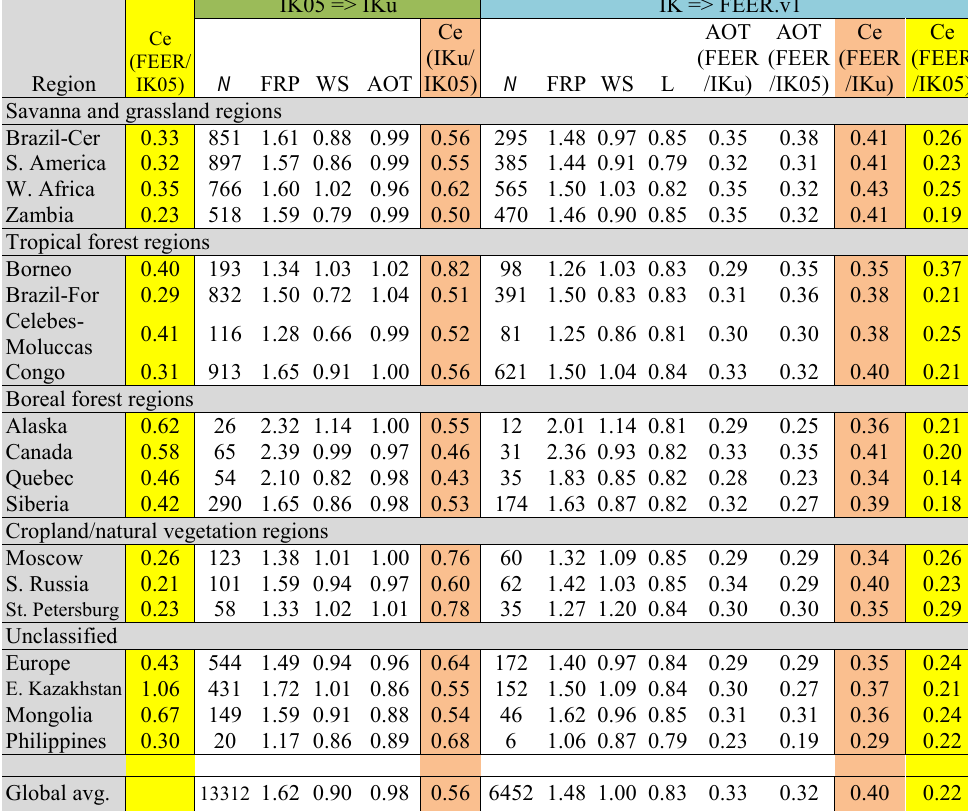
Table 6. The observed changes of C e and intermediate parameters from the original Ichoku and Kaufman (2005) method (IK05) to FEER.v1 is shown here for the regions listed in Table 5. The values in the yellow highlighted column on the left-hand side are the observed changes in C e from IK05 to FEER.v1 from Table 5. The subsequent columns outline the sample size and mean parameter changes during the process of deriving the predicted changes in C e from IK05 to FEER.v1 according to Eqs. (16), (17), and (18), the results of which are highlighted in orange and yellow. The “IK ⇒ FEER.v1” on the first header row indicates that both the IKu to FEER.v1 and IK05 to FEER.v1 transitions are included in the columns beneath. Both Terra and Aqua data were used in these calculations.